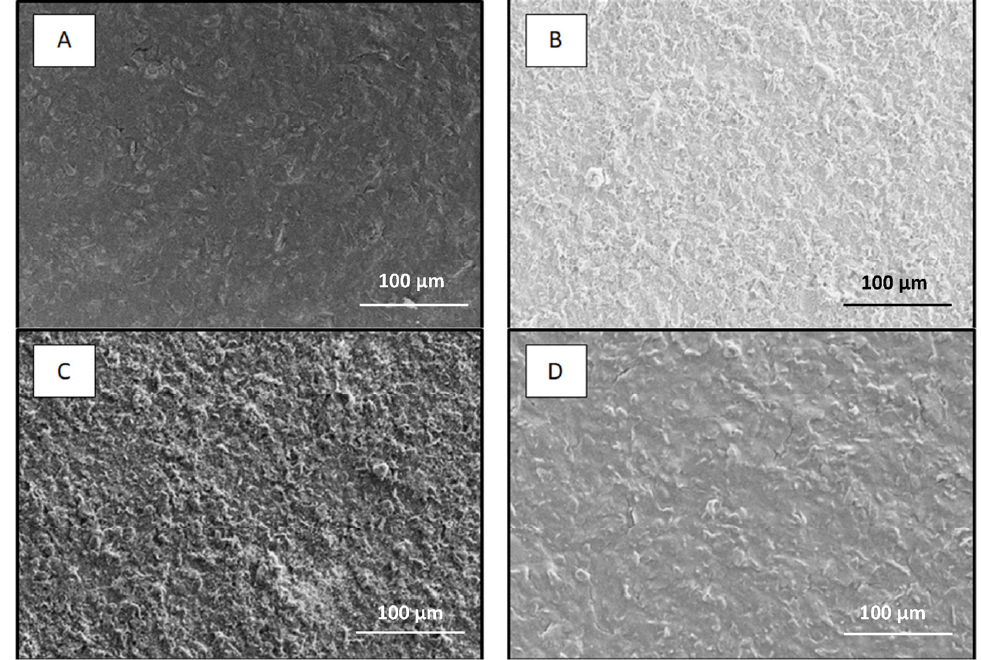
5 of 19 Figure 1. Cyclic voltammograms of the electro-polymerization of pyrrole (0.1 M) in the absence